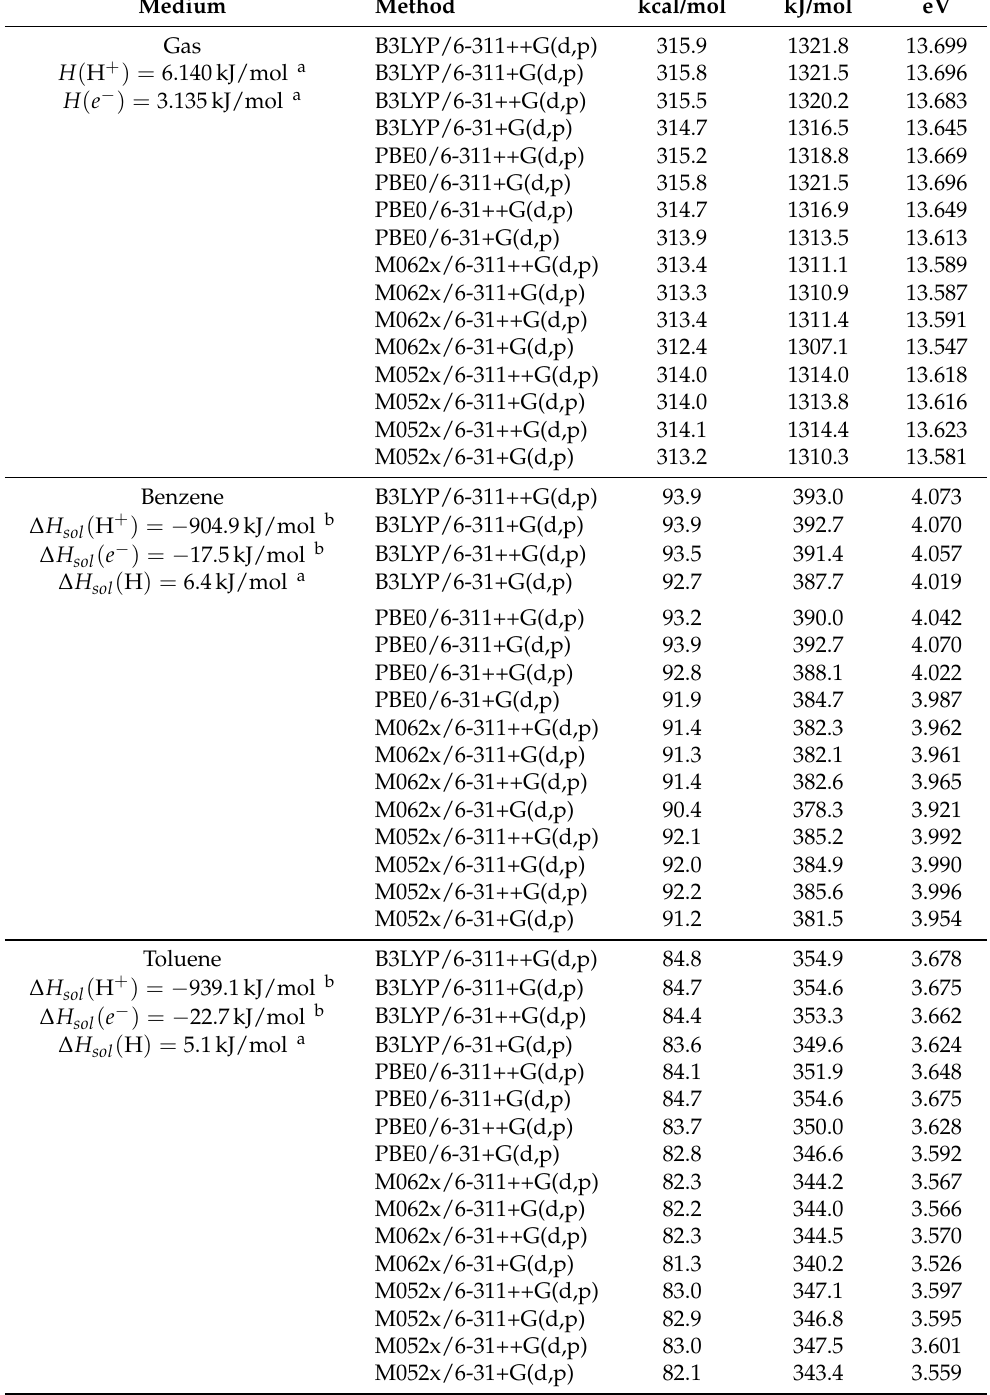
Table 3. Ionization enthalpies (IP H ) of the H-atom in common environments. As already noted in the caption of Table 2, the results using the basis sets 6-311+G(d,p) and 6-311G(d,p), and 6-31+G(d,p) and 6-31G(d,p) are identical. Likewise, including more polarization functions, G(d,p) → G(2d,2p) or 6-311++(3df,3pd), has no impact on the values presented